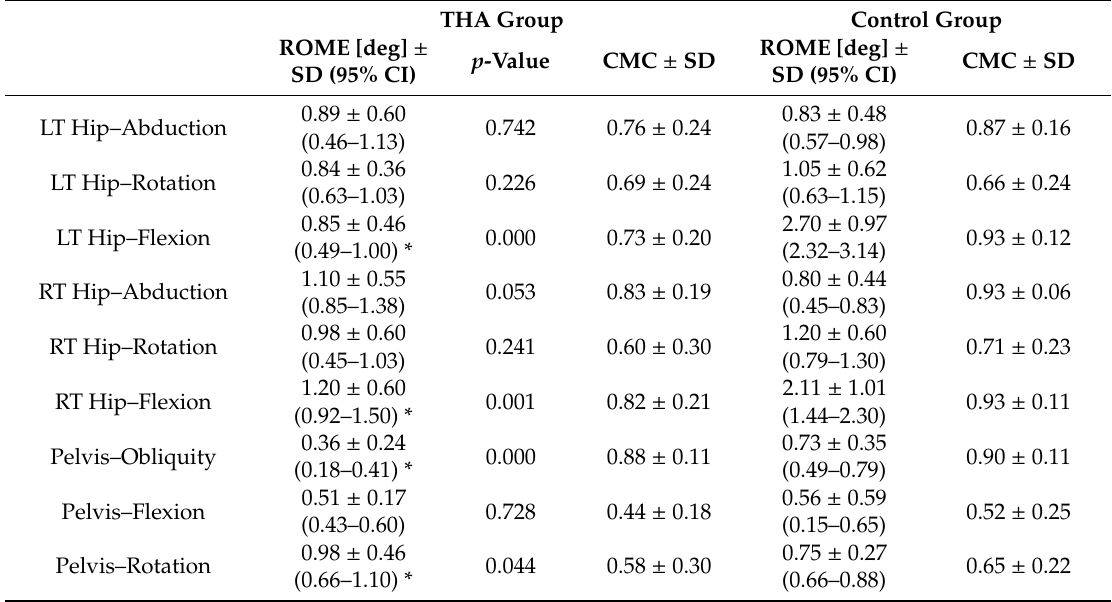
Table 4. Validation results of the 3D range of motion (ROM) of the left (LT) and right (RT) hip and pelvis in both groups. Shown are the ROM error (ROME) ± SD (95% CI) and the coe ffi cient of multiple correlation (CMC) ± SD. An asterisk indicates a significant di ff erence between the THA Group and the Control Group. The corresponding p -values are given.